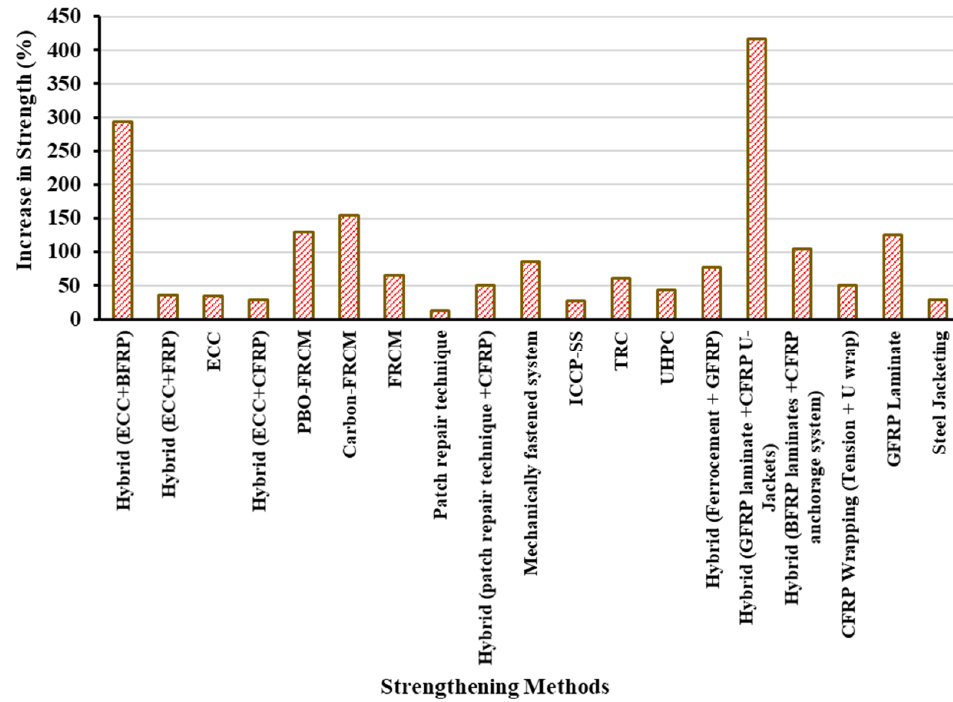
Figure 22. Comparison of strength enhancements using various strengthening techniques.